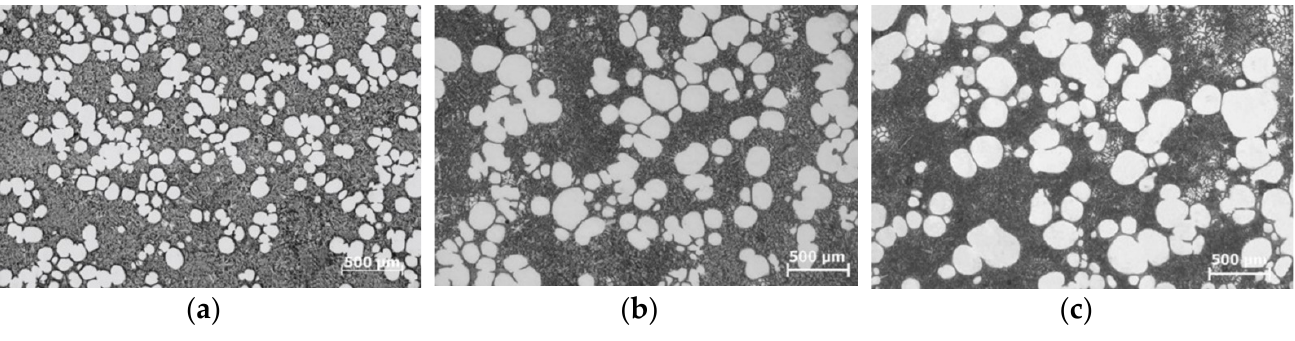
Figure 20. Morphological evolution of spheroidal α -Mg particles in AZ91D alloy during isothermal shearing at low shear rate at 589 °C for different times, ( a ) 0 min; ( b ) 70 min; ( c ) 110 min. Reprinted with permission from Ref. [190]. Copyright 2006 Elsevier.